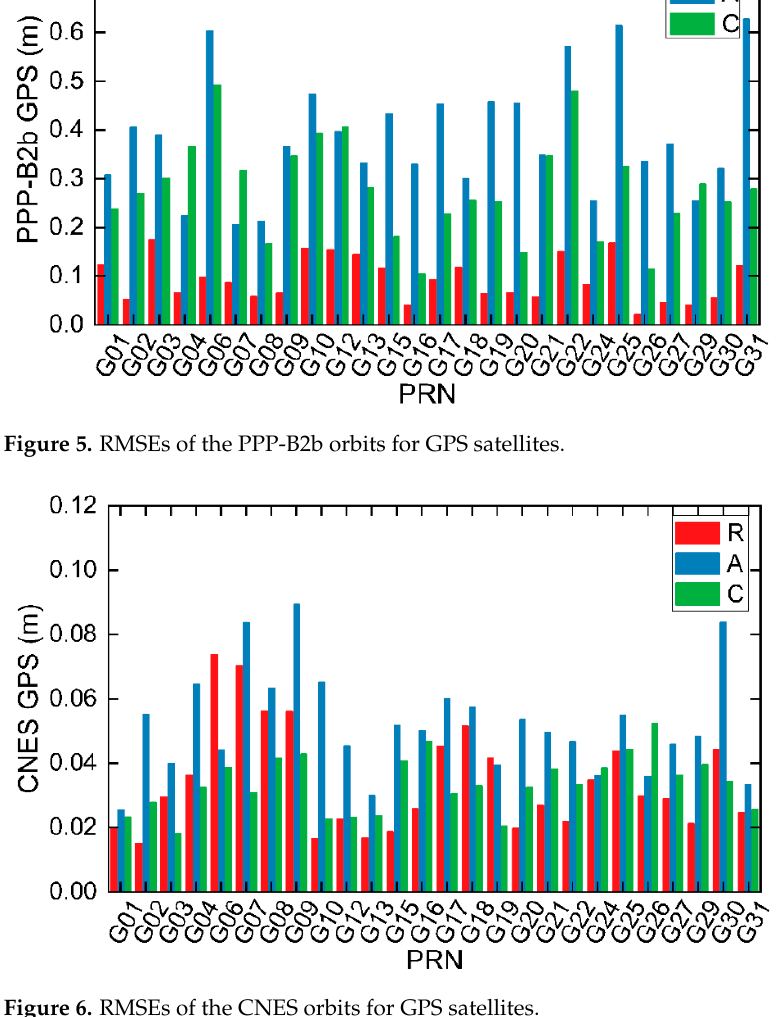
Figure 6. RMSEs of the CNES orbits for GPS satellites.